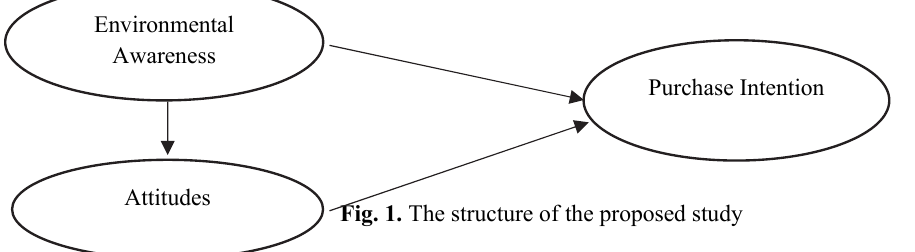
Fig. 1. The structure of the proposed